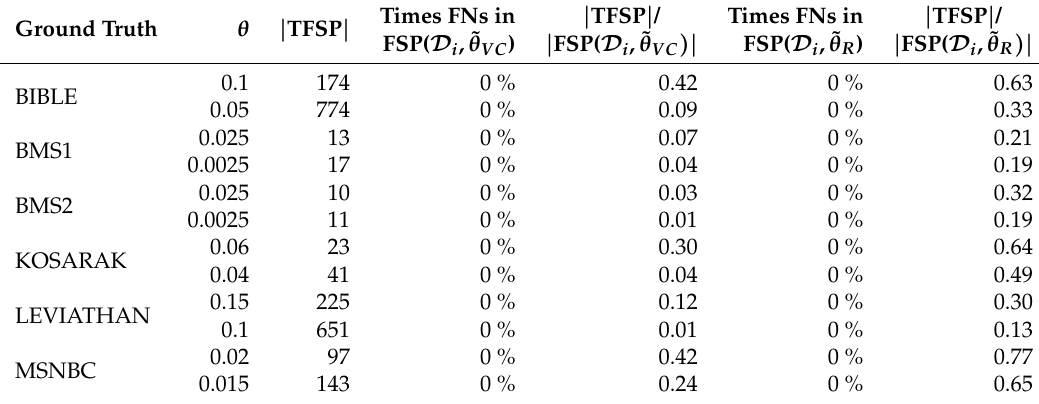
Table 6. Results of our algorithm for the TFSPs with guarantees on the false negatives in 4 pseudo-artificial datasets D i for each ground truth. The table reports the frequency thresholds θ used in the experiments, the number of TFSPs in the ground truth, the number of times the output of the algorithm misses some TFSPs using ˜ θ VC = θ − µ VC /2 as frequency threshold and the average fraction of sequential patterns that are TFSPs in the output using such frequency threshold, the number of times the output of the algorithm misses some TFSPs using ˜ θ R = θ − µ a /2 and the average fraction R of sequential patterns that are TFSPs in the output using such frequency threshold.